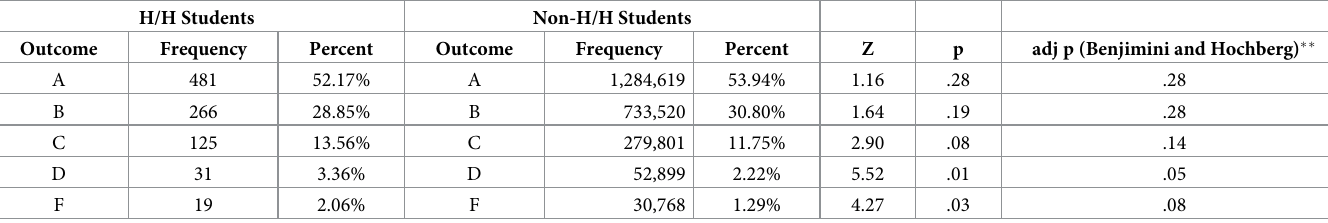
Table 2. Graded performance by course instance (H/H vs Non-H/H designated students, 2012–2018).